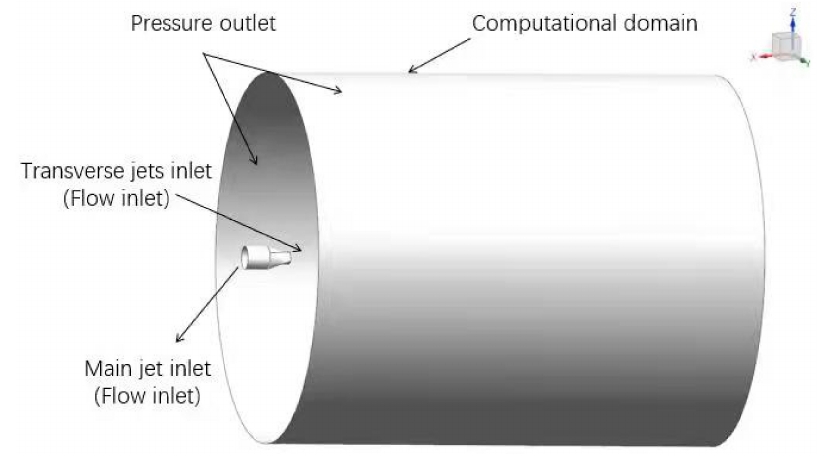
Figure 2. Computational domain.